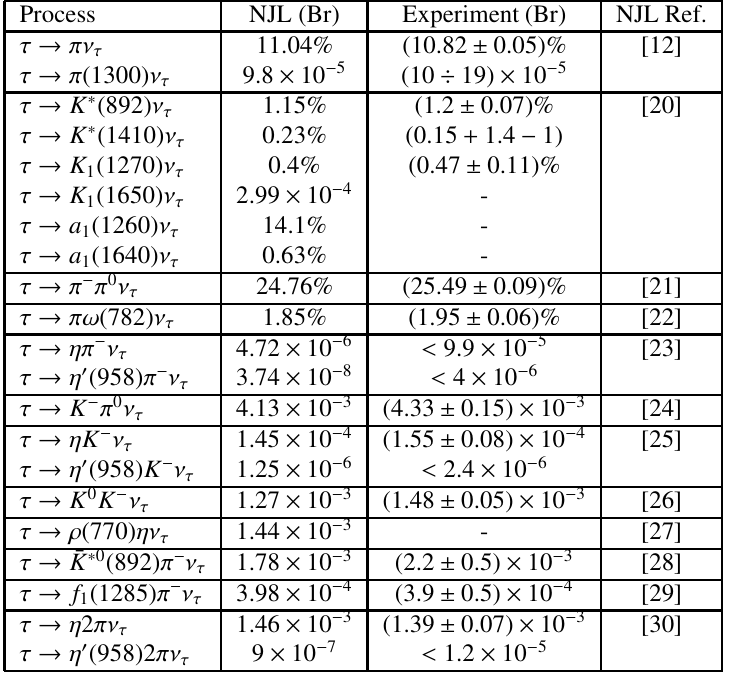
Table 1. Comparison of NJL model predictions for τ lepton decay branching fractions with experimental